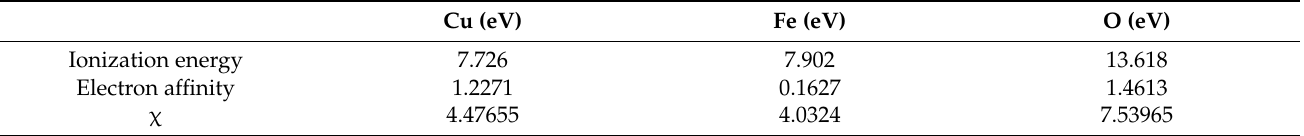
Table 3. Value of electronegativity of each